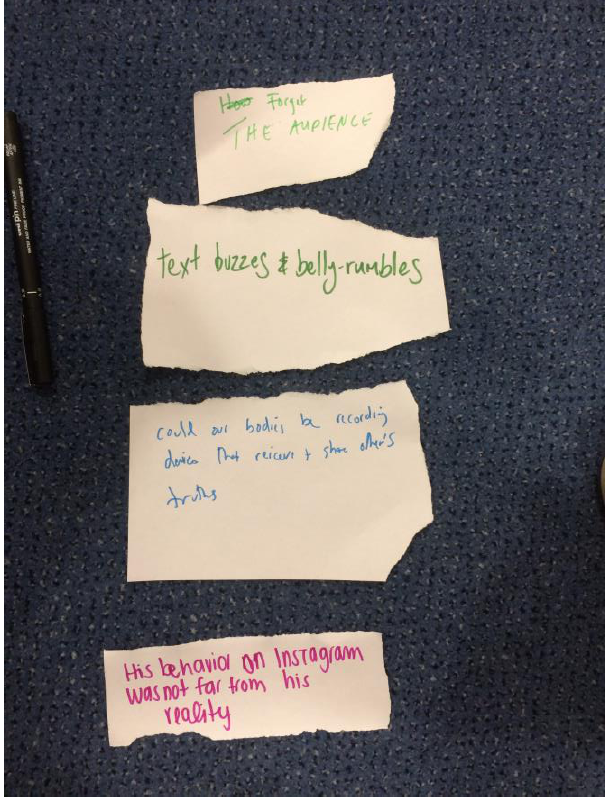
FIGURE 1: FROM DEVIL'S DYKE